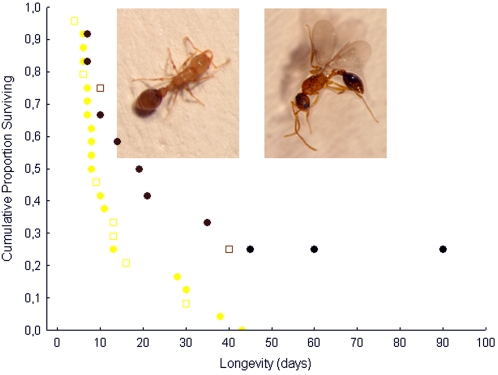
Lifespan of groups of Cardiocondyla queens.Groups of queens, which all mated with winged males (right, brown symbols), lived on average significantly longer than groups of queens, which all mated with a wingless male (left, yellow symbols), independent of whether queens were reared under stressed (filled dots) or unstressed conditions (open rectangles). Black dots indicate censored data, e.g., groups of queens still alive at the end of the experiment.